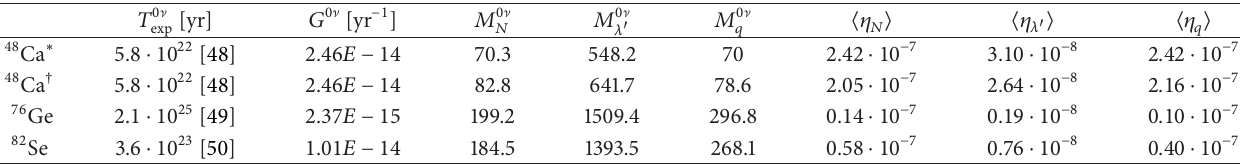
Table 4: Upper limits for Majorana neutrino mass parameters together with the other components of the 0 ] 𝛽𝛽 decay halftimes: the experimental lifetimes lower limits, the phase space factors, and the nuclear matrix